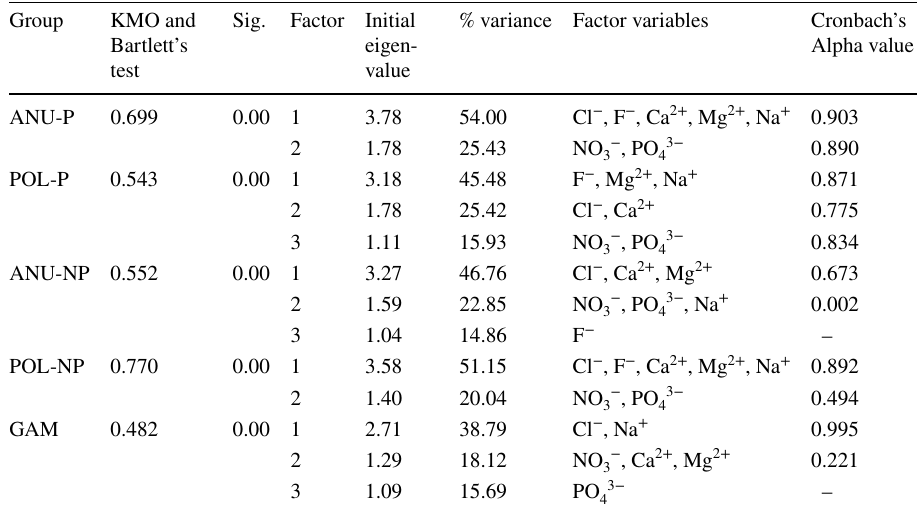
Table 7 Factorial analysis (FA) results for primary